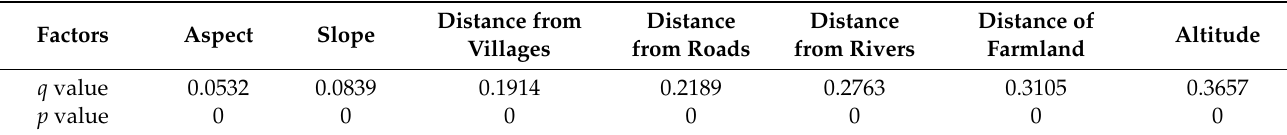
Table 2. Single-factor detection results of influence